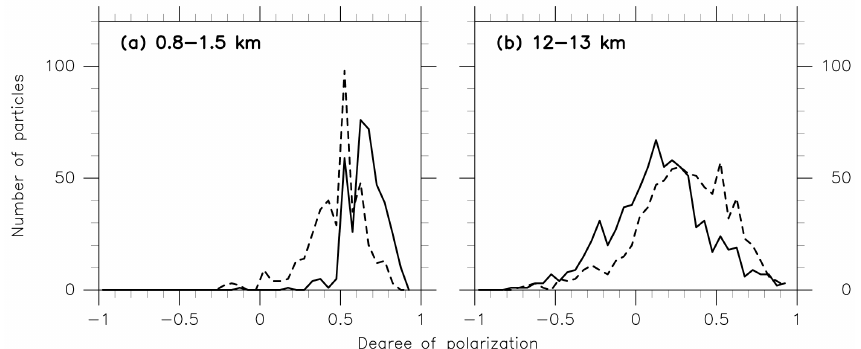
Figure 4. Frequency distributions of the degree of polarization (DOP) in 0.05 bins from the results shown in Fig. 3 at (a) 0.8–1.5km (water clouds) and for (b) 12–13km (ice clouds). For both panels, the solid curves are for the CPS (with the configuration in Fig. 1), while the dashed curves are for the PS2-type CPS (last paragraph of Sect.